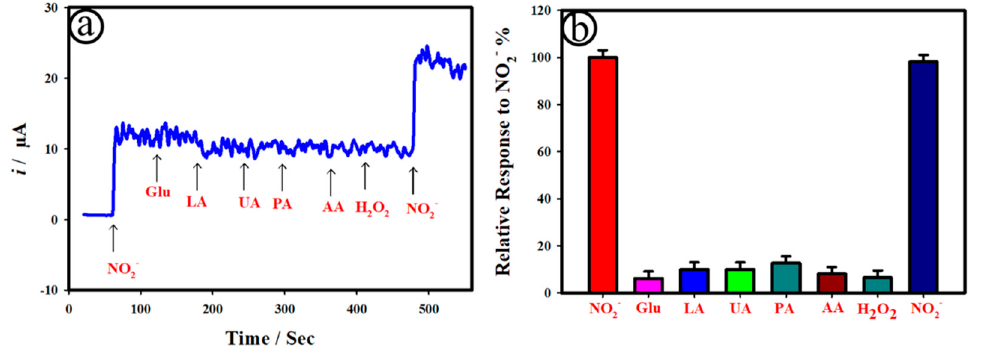
Figure 6. ( a ) i -t curve of the AuNC@AuDS|CF microelectrodes recorded upon addition of 100.0 nM NO 2- , 1.0 µM glucose (Glu), 1.0 µM lactic acid (LA), 1.0 µM uric acid (UA), 1.0 µM paracetamol (PA),